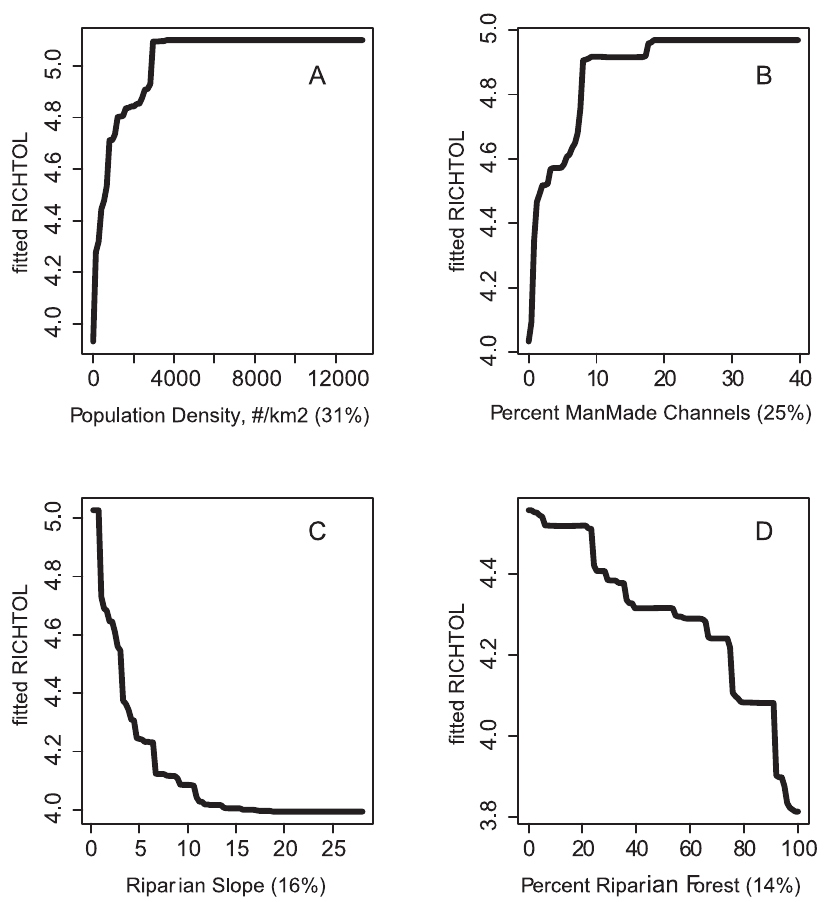
Figure 2. Partial dependency plots for variables in BRT model for RichTOL for the Full Region. Boosted regression tree partial dependency plots show the response form of average taxa tolerance (y-axis = fitted function of RichTOL) based on the effect of individual explanatory variables with the response of all other variables removed (development data set). Shown in order of model importance: (A) population density (numbers/km 2 ), (B) percent manmade channels, (C) riparian slope and (D) percent riparian forest, model R 2 =0.77. The relative contribution of each explanatory variable is reported in parentheses. Refer to Table 1 for variable definitions. The top two variables for the Full Region model showed potential threshold type responses for urbanization variables and the third variable, a natural factor, is likely acting as an urban surrogate (riparian slope). The final variable, a measure of riparian disturbance follows a more linear response and along with urbanization variables was a common explanatory variable in most models among the different